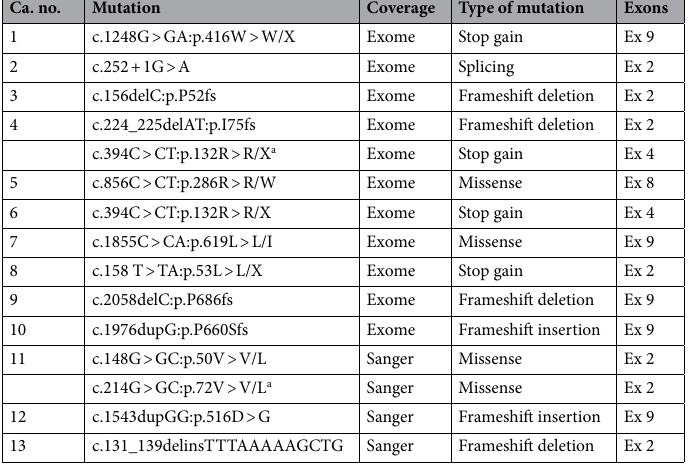
Table 2. RNF43 mutations in discovery and secondary cohorts of CRC. a Same case carried two